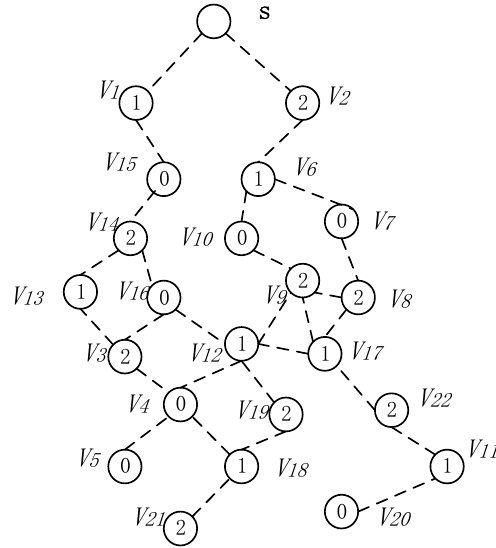
Figure 13. Original physical link.